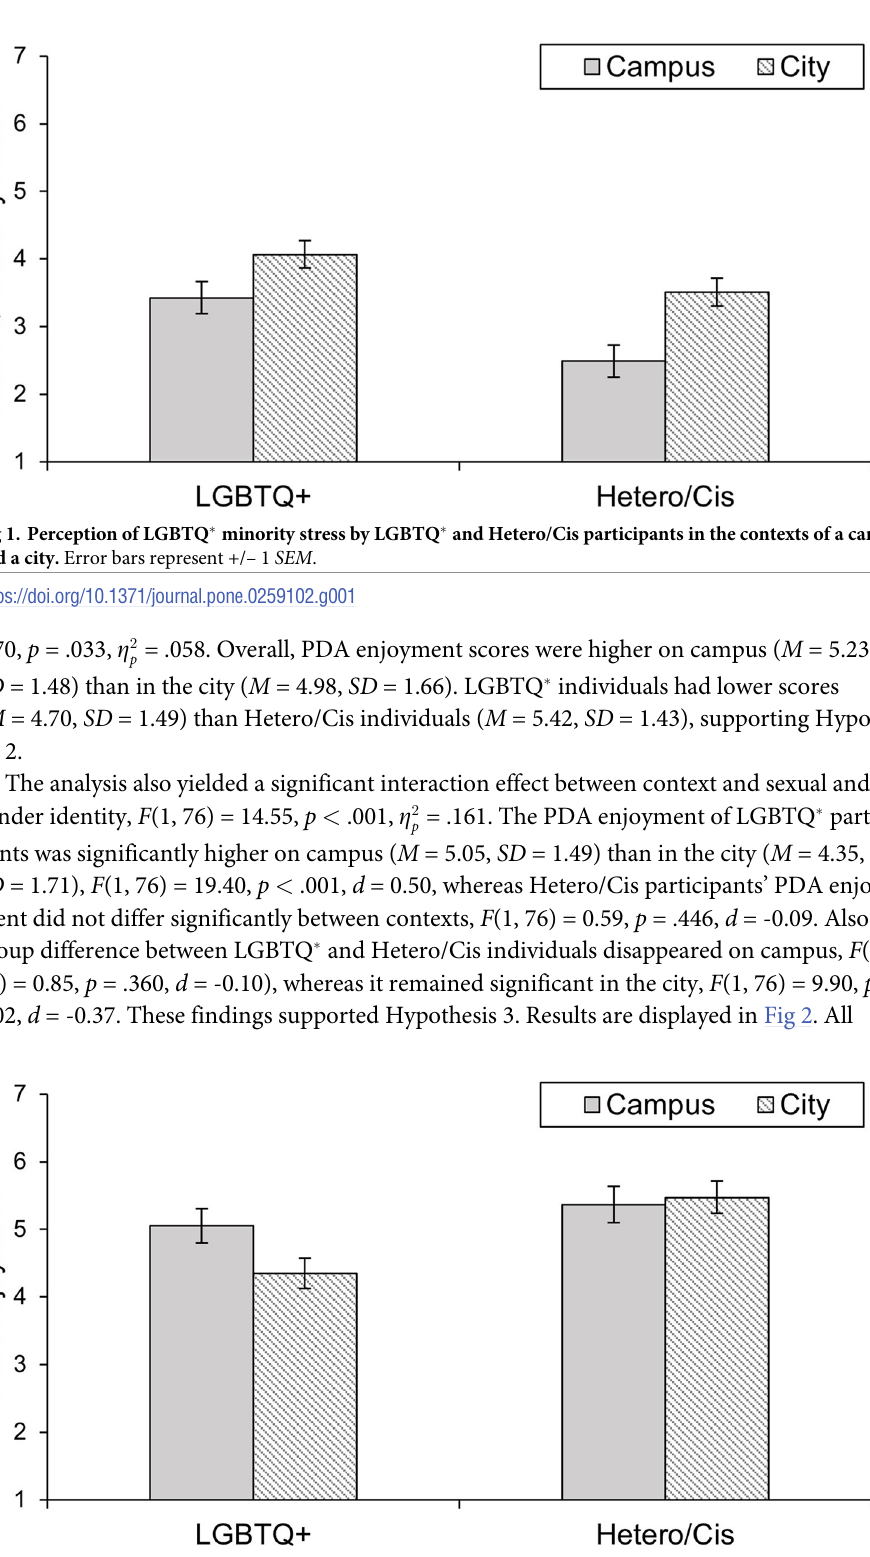
PLOS ONE | https://doi.org/10.1371/journal.pone.0259102 November17,